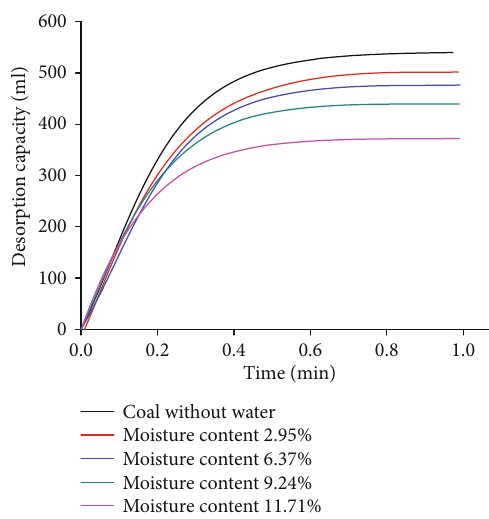
Figure 7: Comparison diagram for the change laws of the gas desorption amounts with time under di ff erent water content